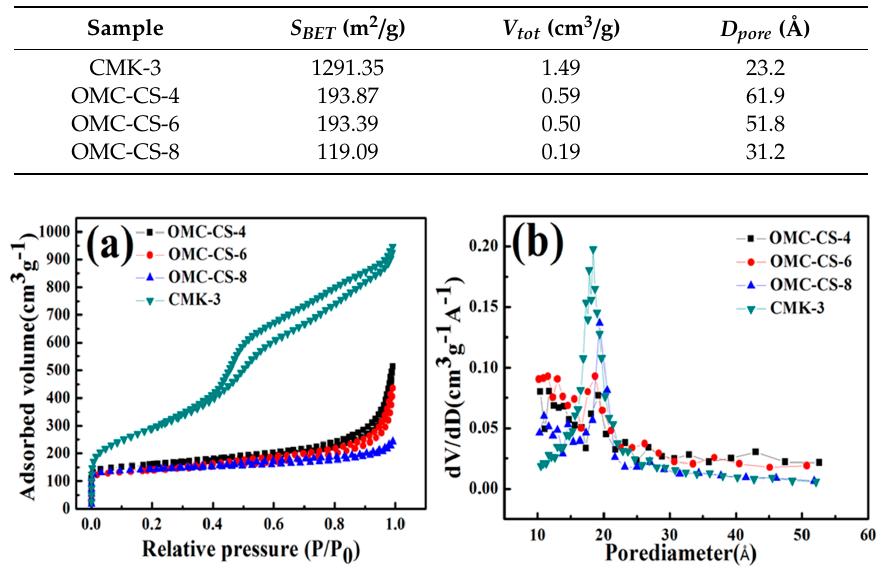
Figure 3. ( a ) Nitrogen adsorption-desorption isotherms at 77 K of CMK-3 and OMC-4,6,8, ( b ) Pore size distribution of CMK-3 and OMC-4,6,8.